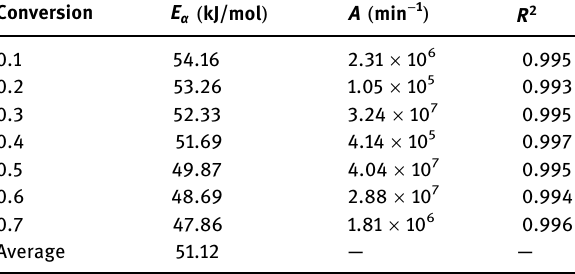
Table 7: Combustion kinetic parameters of sample K4 Conversion